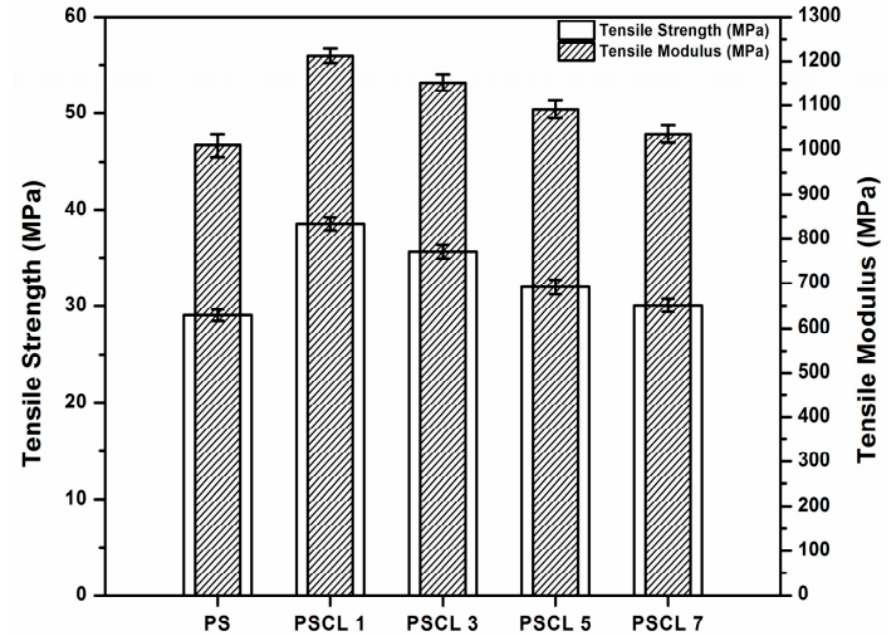
Figure 6. Tensile strength and tensile modulus of polystyrene and its Co-Al layered double hydroxide nanocomposites. Adapted from Suresh, K., Pugazhenthi, G., and Uppaluri, R. Properties of polystyrene (PS)/Co-Al LDH nanocomposites prepared by melt intercalation . Mater. Today. 2019 . 9: 333-350. With the kind permission of Elsevier [112]. Table 5. Selective studies on mechanical properties of LDH-polymer nanocomposites.